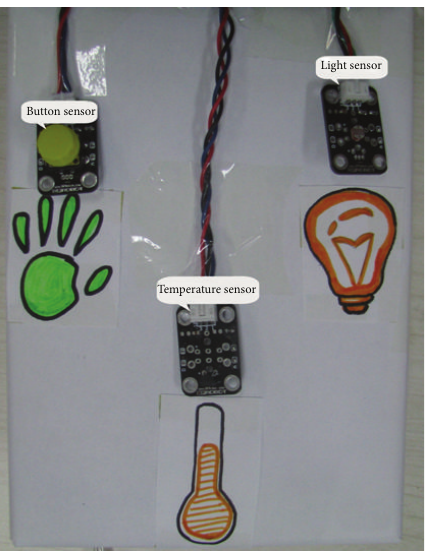
Figure 3: Physical sensors in T-Maze.